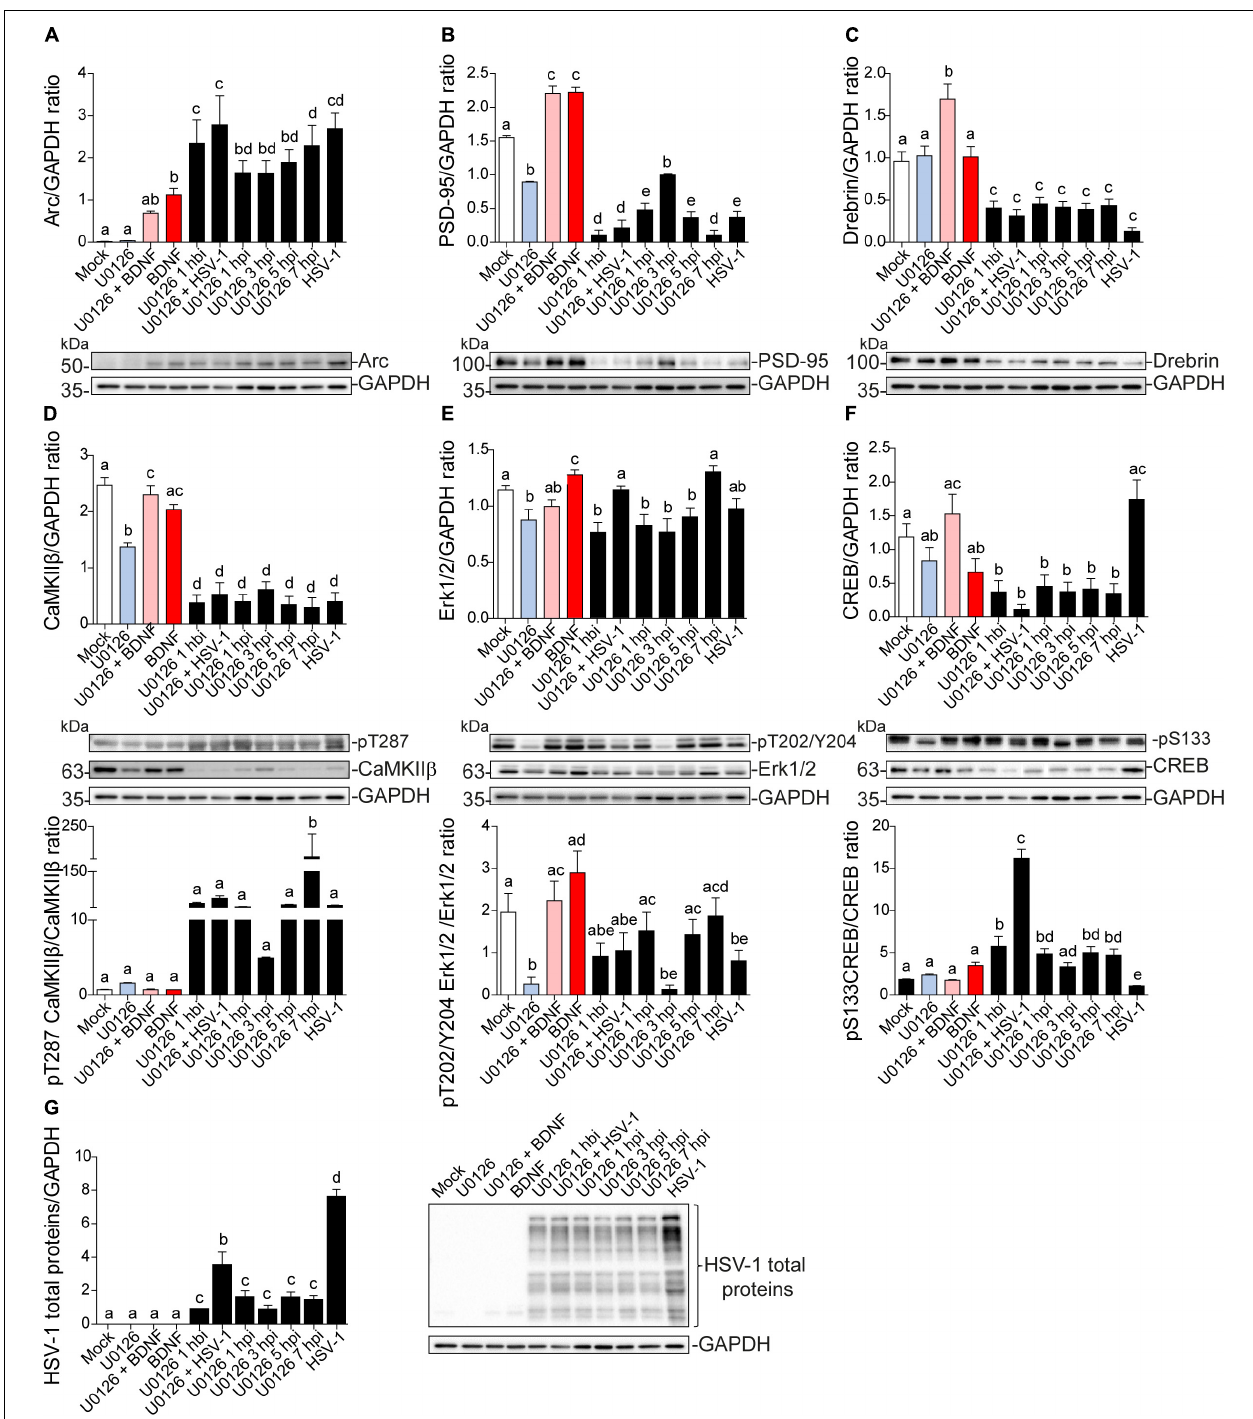
FIGURE 8 | Dendritic protein levels during HSV-1 neuronal infection is controlled by Erk-independent signaling. Immunoblot analyses showing protein total levels at 8 hpi. (A) Arc, (B) PSD-95, (C) Drebrin, (D) CaMKII β , (E) Erk1/2, (F) CREB and, (G) HSV-1 total proteins. BDNF was used as a positive control of Arc expression and the U0126 MEK inhibitor was added at different time points during the infection and together with BDNF to abolish Arc induction. U0126 1 hbi: 1 h before infection; U0126 + HSV-1: added at the same time; U0126 1, 3, 5, 7, hpi, and HSV-1 at 8 h without inhibitor. Statistical significance was determined by One-Way ANOVA, followed by Tukey’s test. Bars represent the mean ± SD of biological replicates. Different letters above the mean bars apply to significant differences between groups p < 0.05. The blots are representative of three independent experiments.